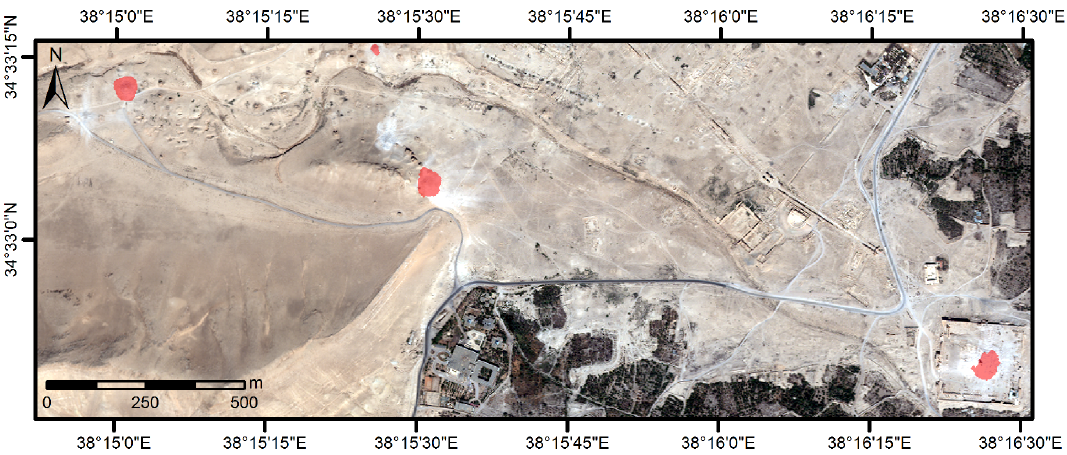
Figure 8. Red: post-processed change map from Figure 7 overlaid on the 2 September 2015 WorldView-2 image reported in Figure 5. All the main damaged areas are correctly identified ( c (cid:13) European Space Imaging/DigitalGlobe).